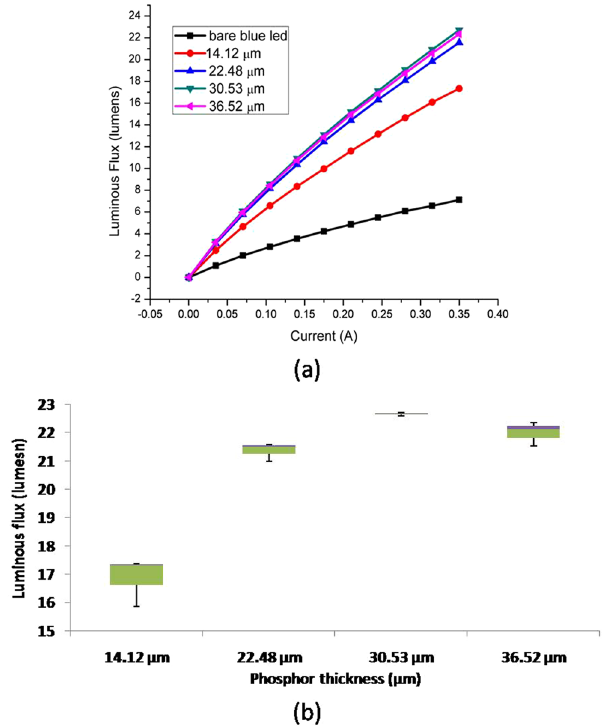
Figure 2. ( a ) Total Lumen flux of the set-up for different phosphor layer thickness at various amount of drive current. ( b )Box plot demonstrating the luminous flux for 3 samples used at each phosphor layer thickness at 350 mA to verify the luminous flux variation at different phosphor